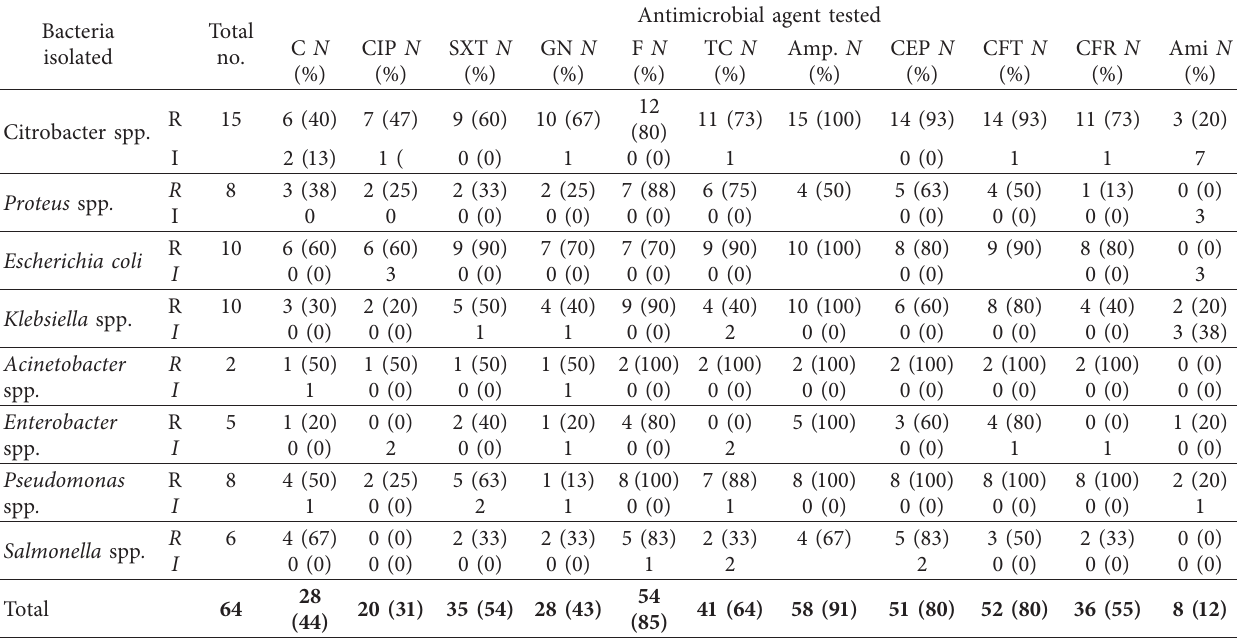
Citrobacter spp.